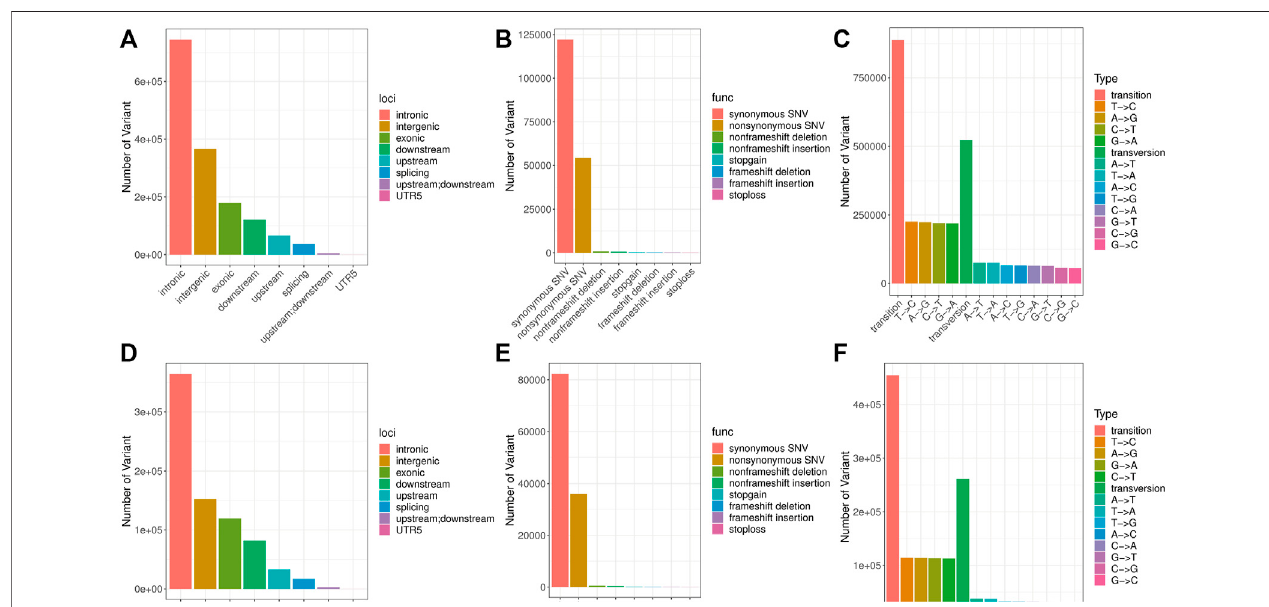
FIGURE 2 | Location information, function note and type distribution of SNPs. Note: (A – C) Location information, function note and type distribution of SNPs in the brain. (D – F) Location information, function note and type distribution of SNPs in the liver.